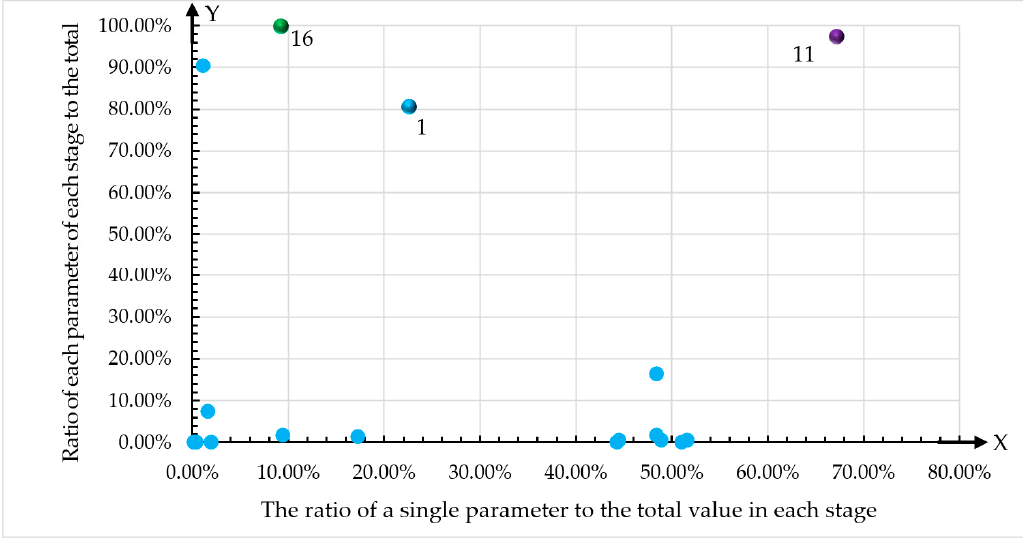
Figure 9. Schematic diagram of the environmental impact contribution of the four-stage cable-stayed bridge.